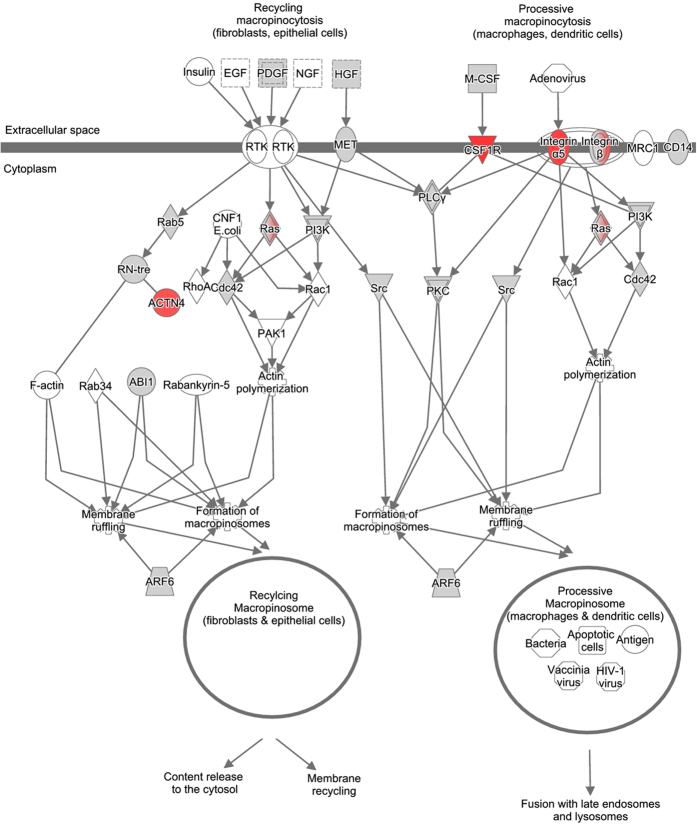
Macropinocytosis signalling pathway, upregulated by L. plantarum TIFN 101 compared to placebo.Green and red coloured genes indicate down or upregulation, respectively. Grey indicates the regulation did not reach significance.